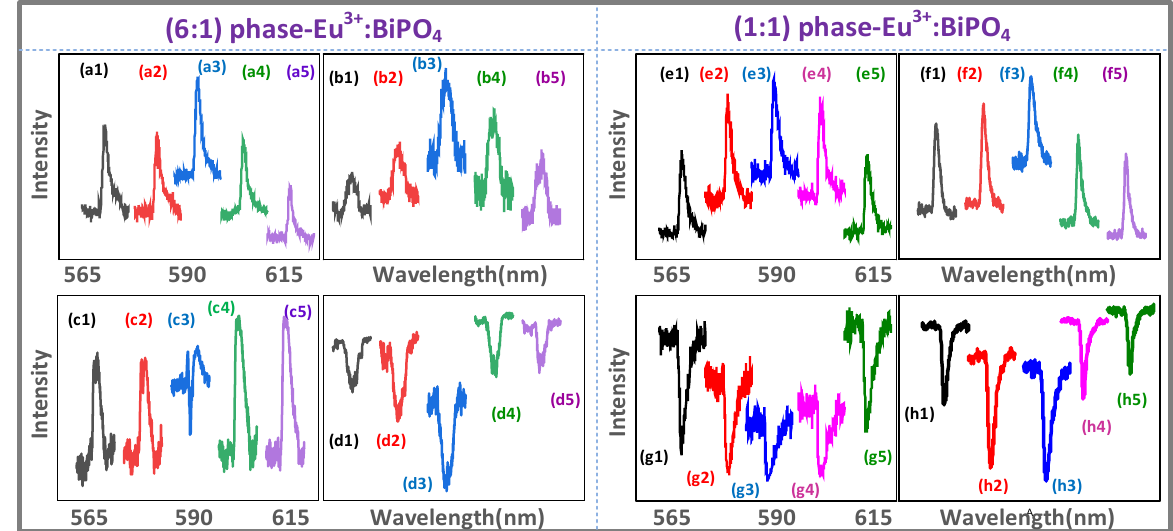
Figure 3. ( a , c ) show self- and cross- interaction of FL observed from Eu 3+ doped BiPO 4 [molar ratio (6:1)] at different E 1 wavelengths (567.4 nm, 584.4 nm, 587.4 nm, 589.4 nm, 612.4 nm) and E 2 scanned from 567.4 nm to 607.4 nm at PMT1 (far detector position) and PMT2 (near detector position), respectively. ( b , d ) show self- and cross- interaction of FL at different E 2 wavelengths (567.4 nm, 587.4 nm, 588 nm, 588.4 nm, 602.4 nm) and E 1 scanned from 567.4 nm to 612.4 nm. ( e – h ) show spectral signal intensity for (1:1) sample, which is same condition as ( a – d ). The time gate = 1 µ s.